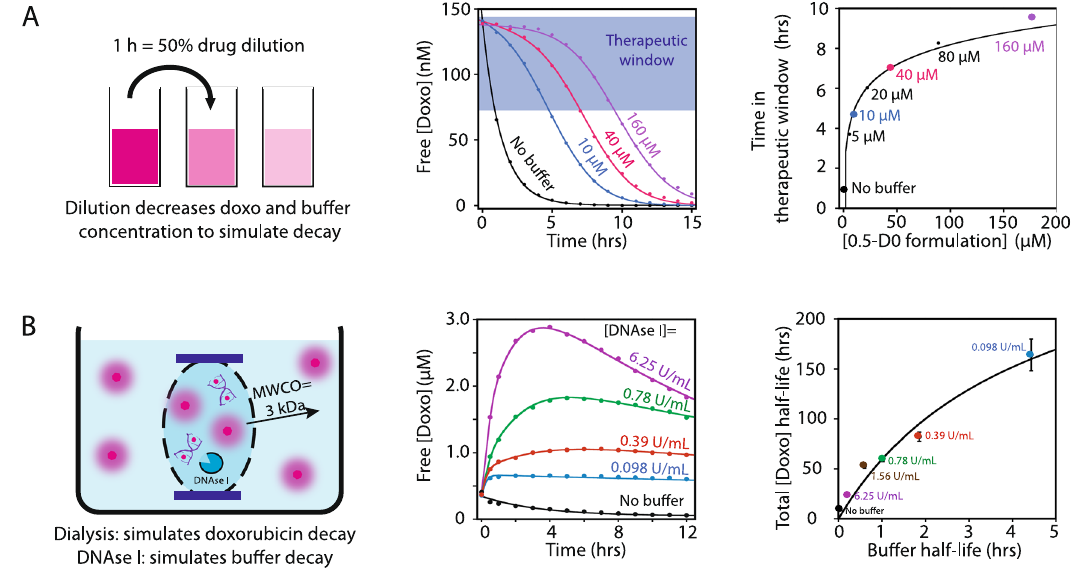
Fig.4|Programmingthedoxorubicinpharmacokineticpro fi leusingmolecular buffers. ( A , left panel) Simulating doxorubicin and buffer degradation using serial dilutions.( A ,middleandrightpanel)Largereservoirsofdrug/bufferformulationof 0.5-D0 maintain the free doxorubicin concentration in an arbitrarily selected therapeuticwindowdepictedbythebluesquarebetween75and150nMforamuch longerperiod despite many dilution cycles (formiddlepanel,black line: no buffer; blue line: 10 µ M reservoir; pink line: 40 µ M reservoir and purple line: 100 µ M reservoir).Datainthemiddlepanelare fi ttedwithequationE11anddataintheright panel with equation E14 (Supplementary Information). ( B , left panel) Simulating doxorubicinclearanceusingadialysiscassetteandbufferdegradationusingDNAse Inucleaseactivitywithformulation0.5-D0.( B ,middlepanel)Thepharmacokinetic